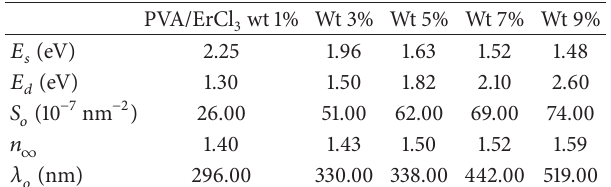
Table 1: The optical parameters for PVA doped with different . concentration of ErCl 3